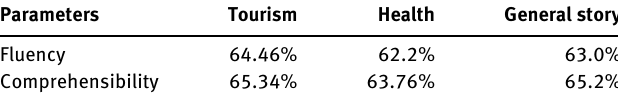
Table 8: Telugu-Tamil MT Evaluation-1.